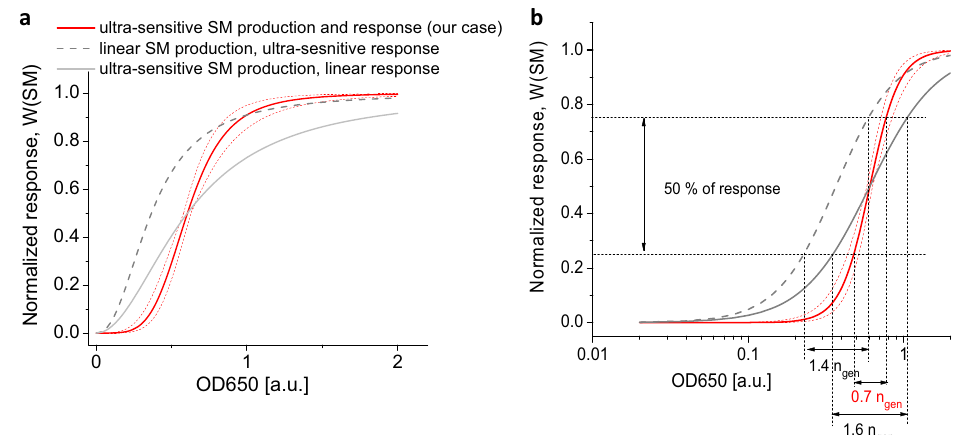
Fig. 6 The importance of the quadratic dependence of signal molecule (SM) on bacterial density (ultra-sensitive SM production) and cooperativity in response to SM (ultra-sensitive response). The maximum normalized response curve (red line), eq S9, as obtained on the basis of experimental data in Fig. 2b, Fig. 4a and presented as a function of bacterial density expressed as linear ( a ) or logarithmic ( b ) optical density, OD650. The conversion of SM concentration to OD650 was performed by Eq. 1, where SM increased, as measured, by the square of bacterial density. The shown error (95% CI) of eq S9 (red dotted line) is due to the uncertainties in values of parameters of Eqs. 1 and 2; A theoretical case, where SM production linearly depends on bacterial density (gray dotted line) or shows a linear response (gray line). Note the much wider window of response for linear SM production or response compared to ultra-sensitive production and response, where 50% of response occurs within the same generation of growing cells ( n gen = 0.7). Therefore, only the ultra-sensitive-response (decoder module) and ultra-sensitive signal molecule production (encoder module) operating in the same communication system give the switch-like response, necessary for the true quorum sensing response (red